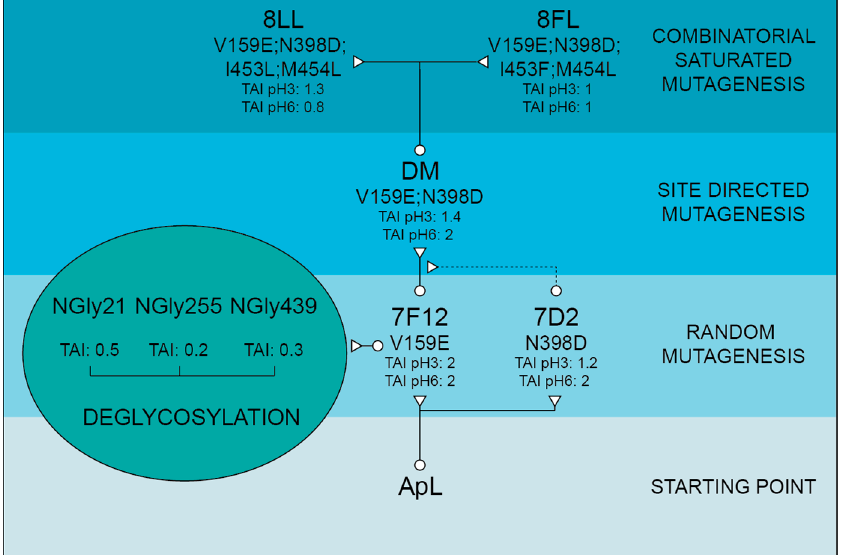
Figure 1. Evolution pathway of α 9H2 -ApL (from bottom to top). Three different approaches were combined to improve the heterologous production of the enzyme or its catalytic activity and shift of optimal pH: random mutagenesis over the whole construction, site-directed mutagenesis over 398th position and combinatorial saturation mutagenesis over 453 rd and 454 th positions. Besides, based on a consensus criterion, the effect of N -glycosylation on 7F12 variant was studied through site-directed mutagenesis of the three putative sites NGly21 (N21S), NGly255 (N256Q; T257P; S258V) and NGly439 (N439S). Mutations accumulated in ApL sequence in the successive engineering steps are shown. TAI indicates total activity improvements (produced either by enhanced lac- case production and/or better catalytic activity) detected for the new variants compared to the ac- tivity of the laccase used as parent in each mutagenesis round (i.e. the fittest laccase of the previous generation).